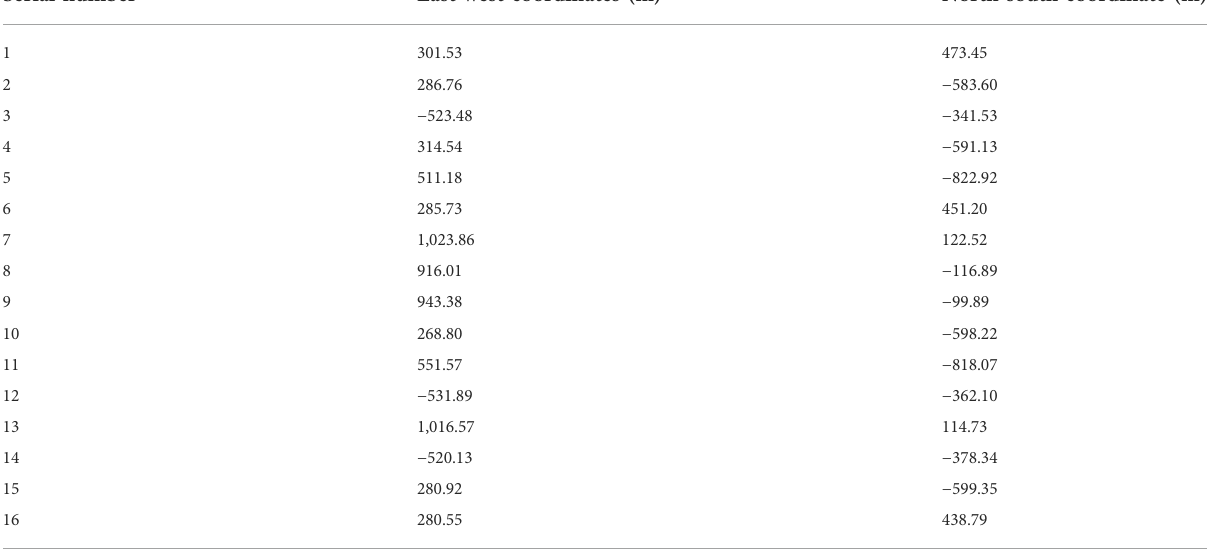
TABLE 1 The coordinates of ground microseismic monitoring stations.